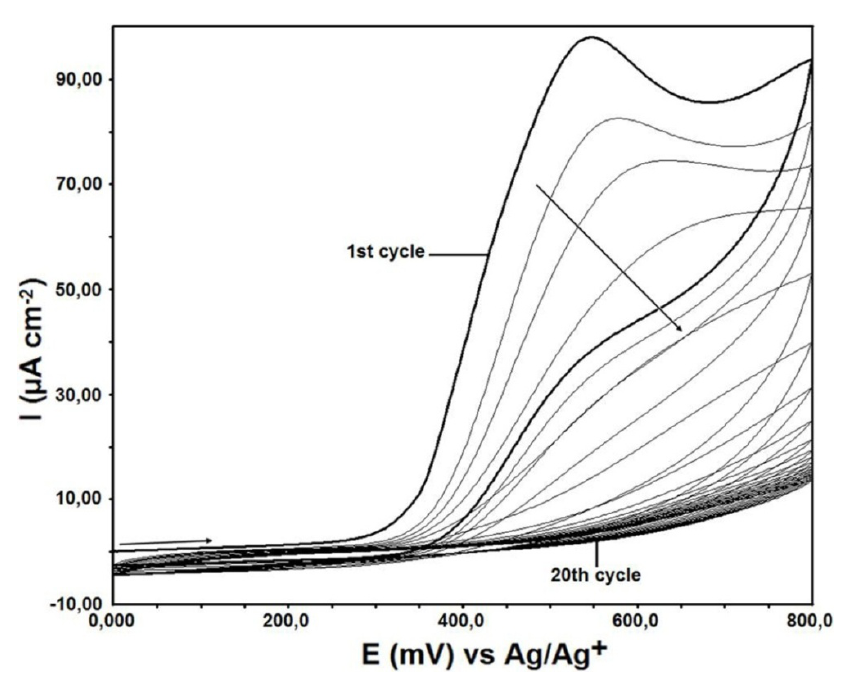
Figure 2. Cyclic voltammogram of 1 mM DTO in 100 mM TBATFB (in MeCN) vs. ). Potential sweep rate is 100 mV·s − 1 Ag/Ag + /(10 mM AgNO 3